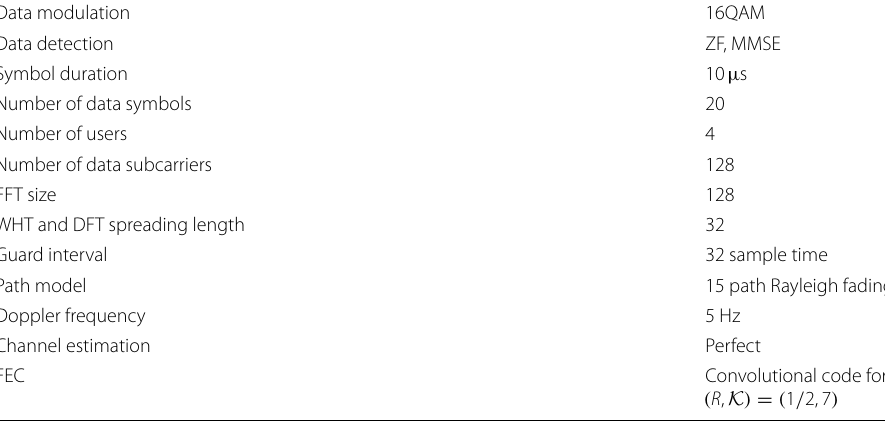
Table 3 Computer simulation parameters